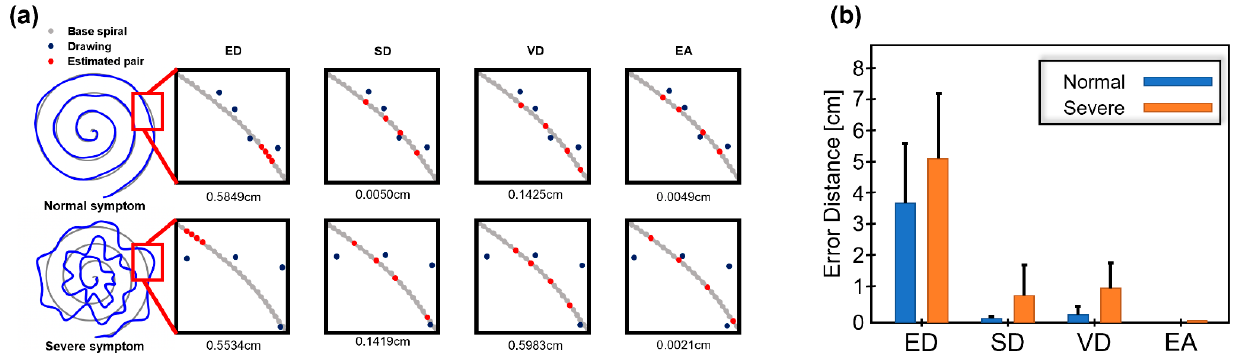
Figure 6. Differentiation of symptom levels in experimental data. ( a ) Examples of normal and poor drawings and estimated pairs from four methods are presented. ( b ) The error errors are shown in mean and standard deviation.